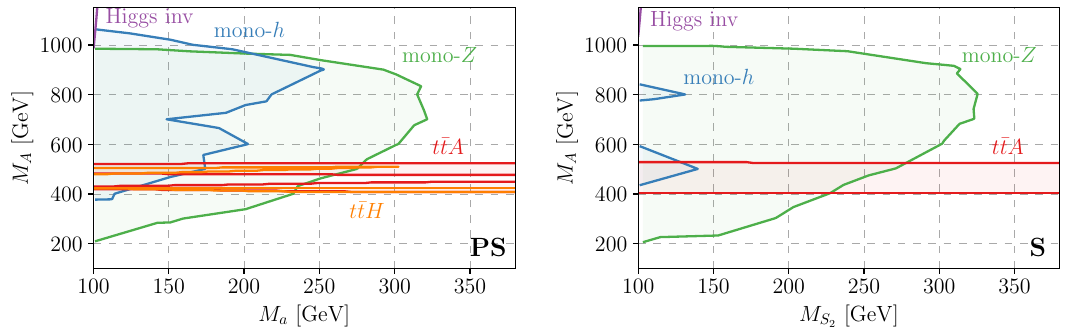
Figure 13 . Overview of the 2 (cid:27) exclusion limits from mono- h , mono- Z , t (cid:22) t resonance (for scalar and psedoscalar mediator) and Higgs to invisible searches (see text for details) in the M for the 2HDM+PS (left) and 2HDM+S (right). In both plots we use the parameters as given in eq. (4.4) and tan (cid:12) = 1.